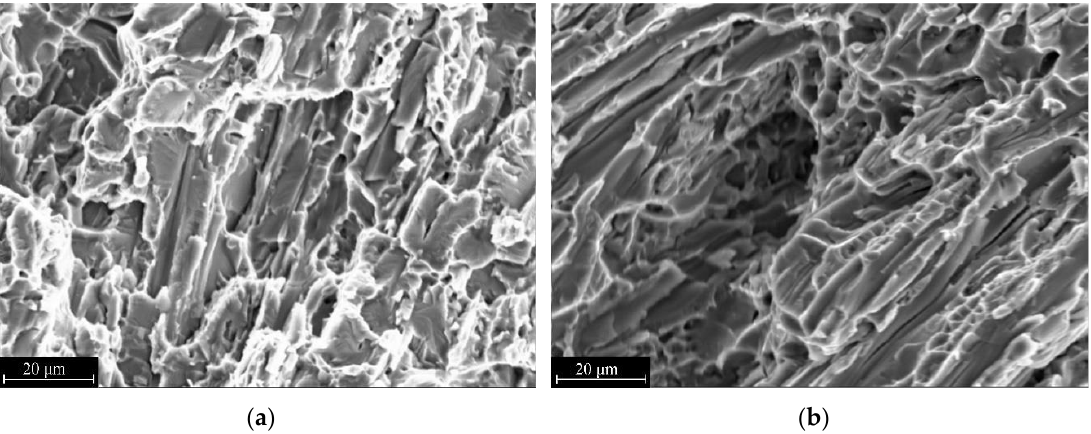
Figure 22. Fragment of ductile fracture of fracture surface of (Ti-TiB)–T110 welded joint, × 1000: ( a ) v eb = 7 mm · s − 1 ; ( b ) v eb = 13 mm · s − 1 .